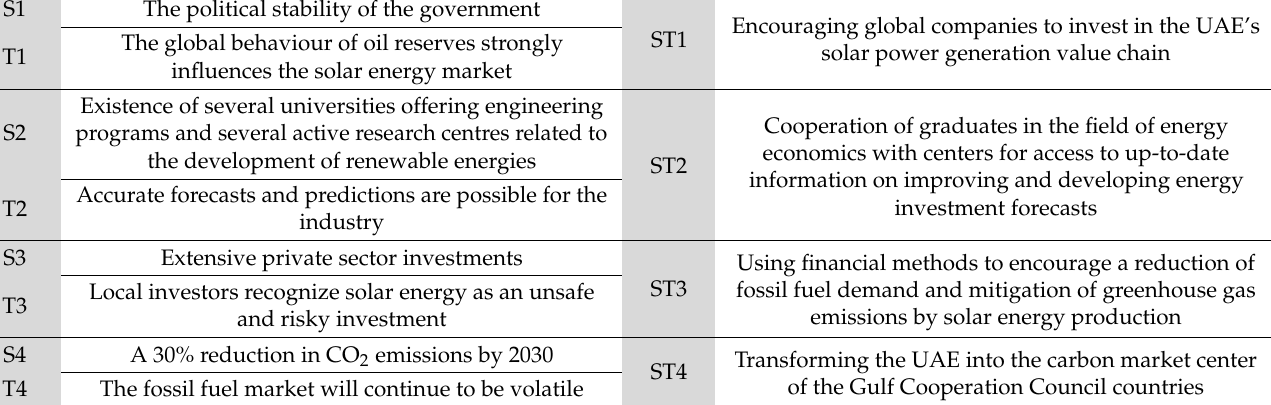
Table 3. ST array of the